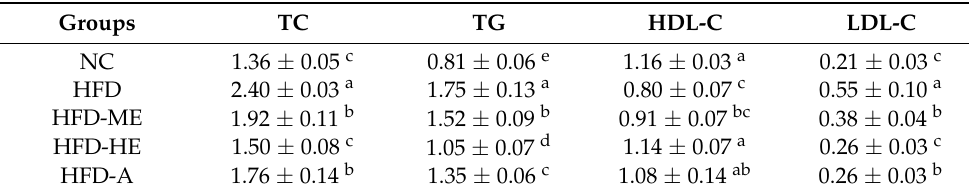
Table 4. Effect of the ethyl acetate fraction of P. frutescens leaves on the blood lipid parameters of STZ-induced diabetic